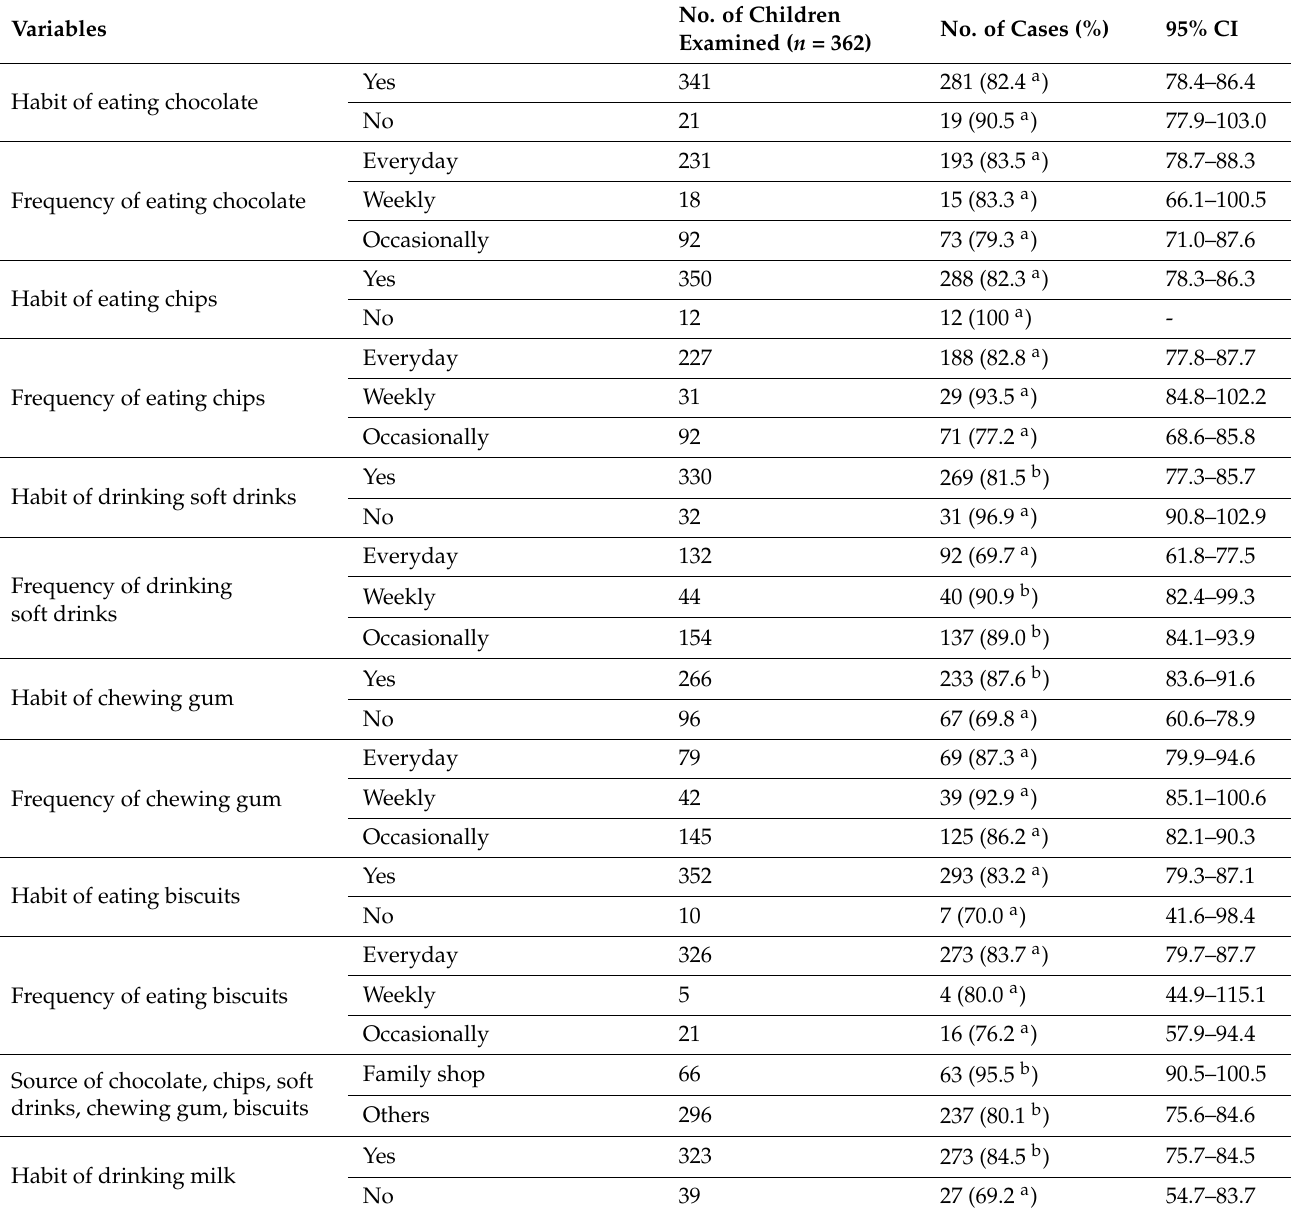
Table 3. Prevalence of dental caries in relation to eating and dietary